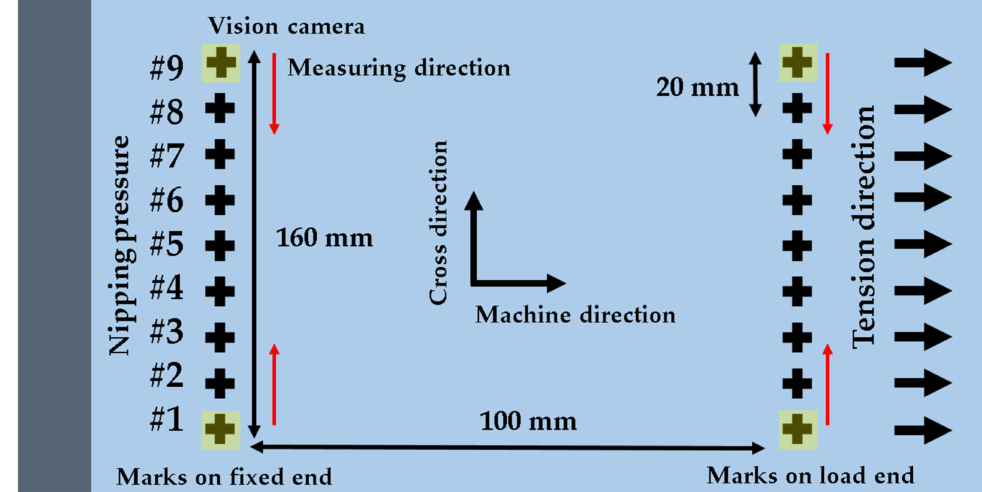
Figure 5. Schematic of the web strain measurement method (top view) with a conventional roller.